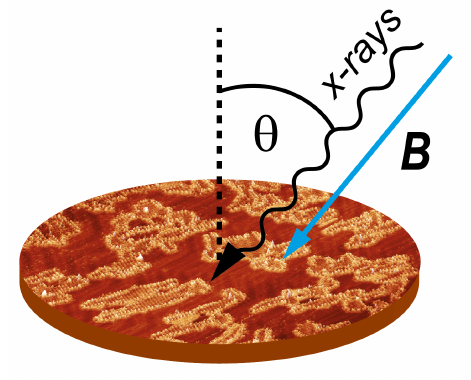
Figure 1. Schematic view of the data acquisition geometry in the X-ray absorption spectroscopy (XAS) experiments. The external magnetic field B is kept parallel to the incident beam and the surface is rotated at a polar angle θ with respect to the surface